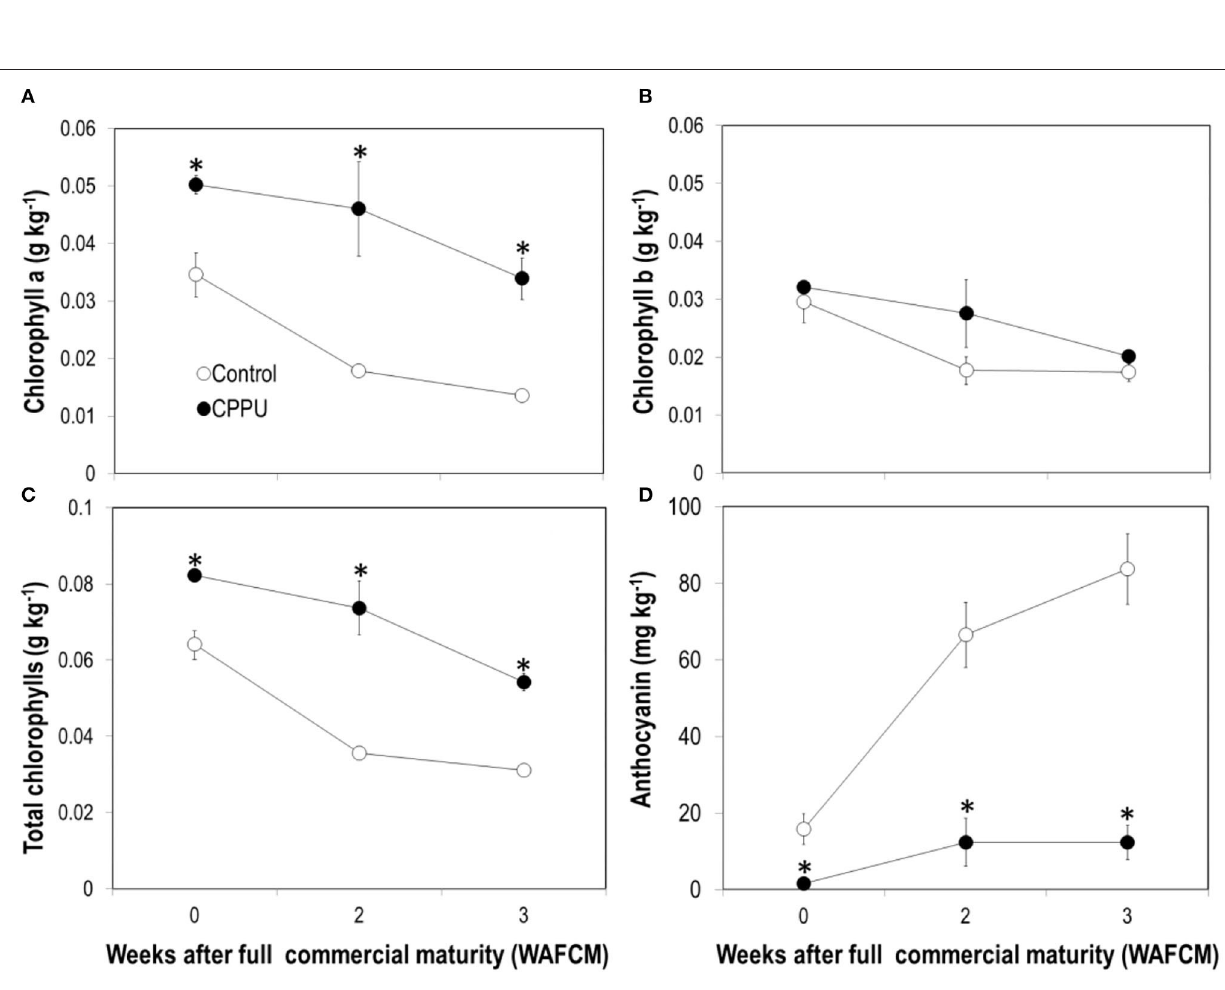
FIGURE 3 | Effect of preharvest application of CPPU on chlorophyll a (A) , chlorophyll b (B) , total chlorophyll (C) , and anthocyanin (D) contents in the pericarp of ripe “Feizixiao” litchi fruit remained on tree. Vertical bar at each data point stands for standard error ( n = 5). *Indicates significant difference between CPPU treatment and the control at p < 0.05, Student’s t